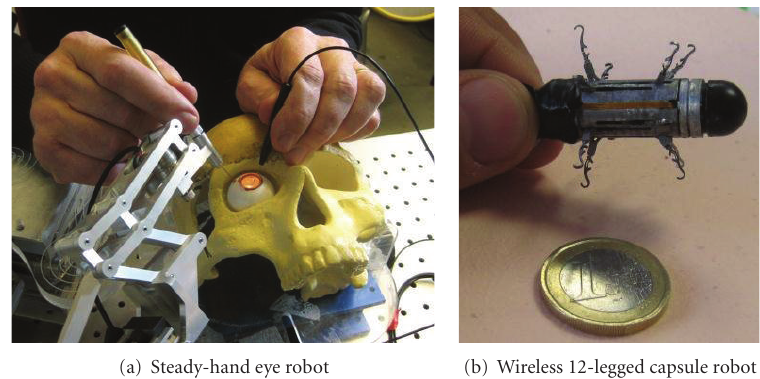
Figure 3: (a) Steady-hand eye robot developed in Johns Hopkins University for retinal microsurgery. This device minimizes hand tremors by sharing the instrument control between the surgeon and the robotic manipulator, allowing precise and steady motion [7]. (b) Pill-size endoscopic capsule robot developed by Sant’Anna School of Advanced Studies and Vanderbilt University with active control for placing its camera in a desired position and direction in the intestine